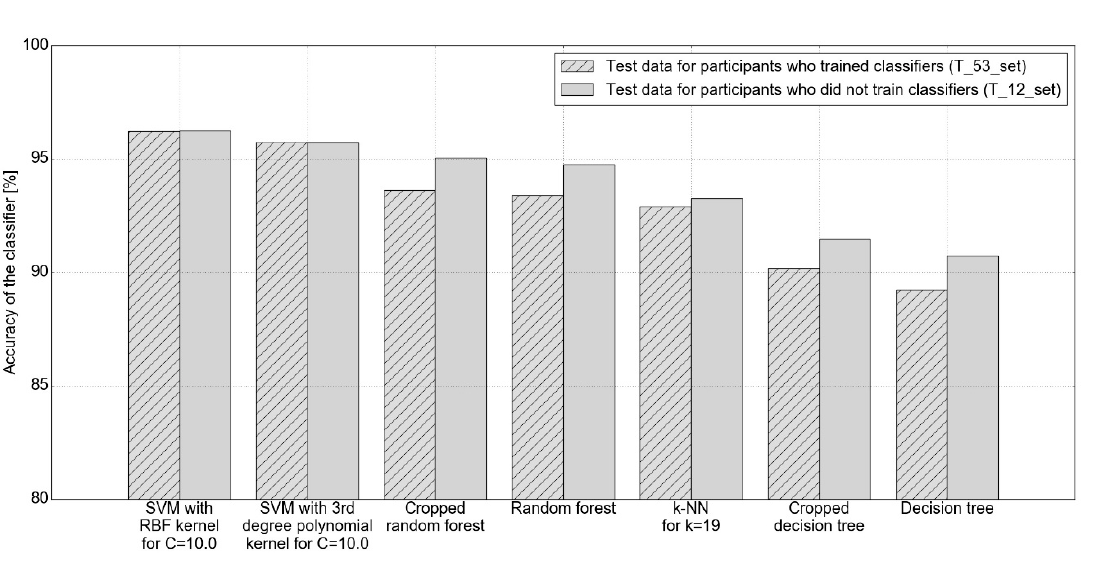
Figure 6. Comparison of the classifiers’ accuracy obtained for the test data from participants who trained the classifiers (T_53_set) and the test data from individuals who did not record the training data (T_12_set). The test data collected directly from the accelerometer and gyroscope (vectors with 6 parameters).